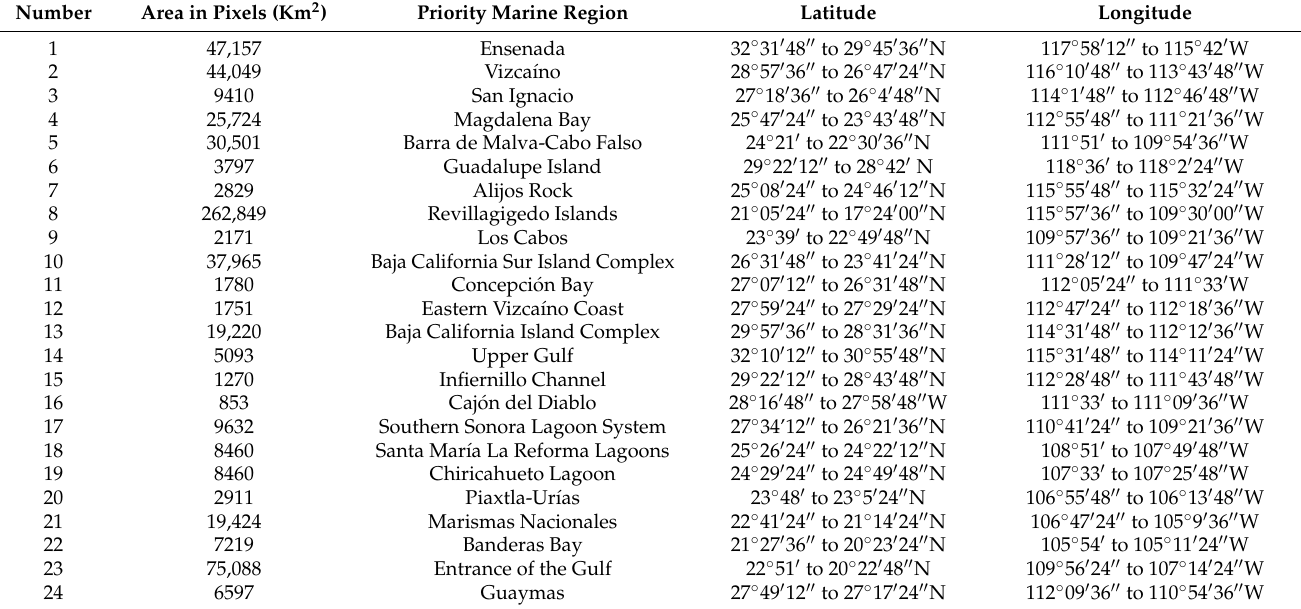
Table 1. List of geographic coordinates of the Priority Marine Regions (PMR) in the Northwest of Mexico. South Californian Pacific and Gulf of